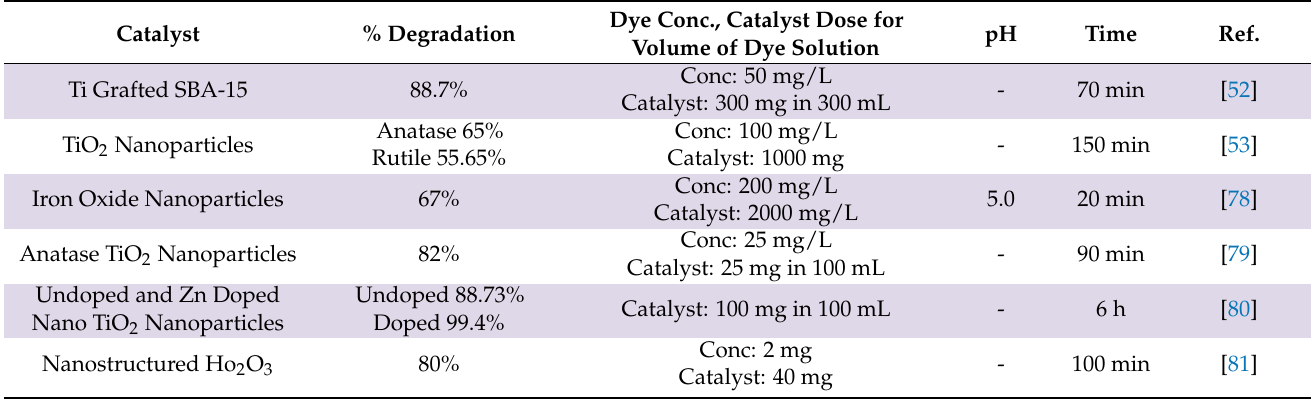
Table 1. Comparison of the results obtained in the present work with literature studies of other researchers for the removal of Solochrome dark blue